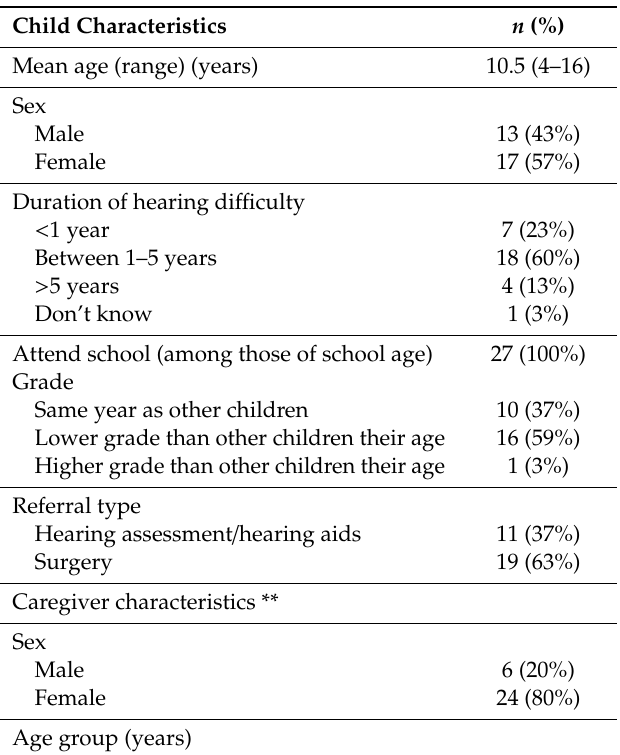
Table 1. Characteristics of the